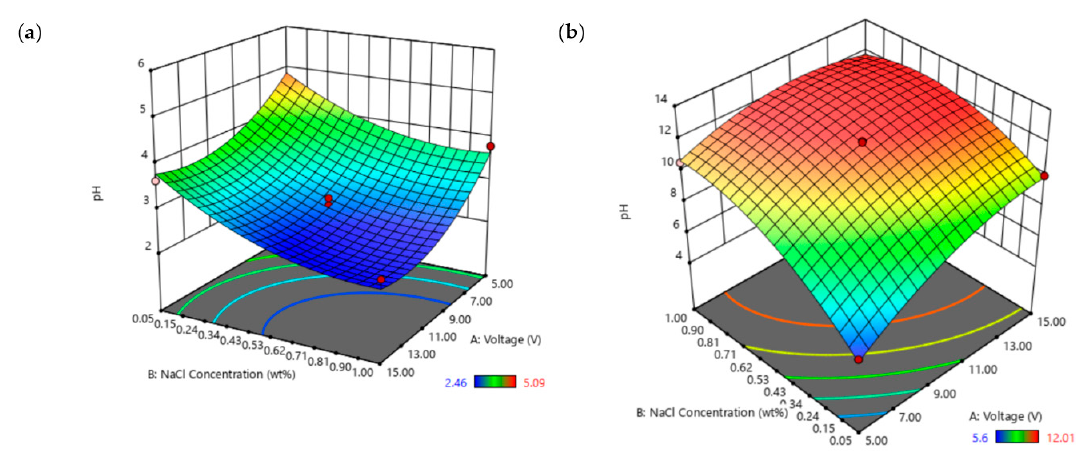
Figure 2. Response surface plot of the pH of: ( a ) AcEW and ( b ) AlEW due to the combined effect of the NaCl concentration and the voltage.